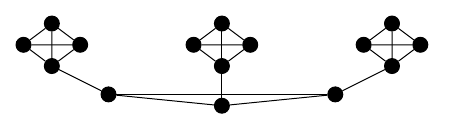
Fig. 1 The Banana tree graph B 3 , 5 .